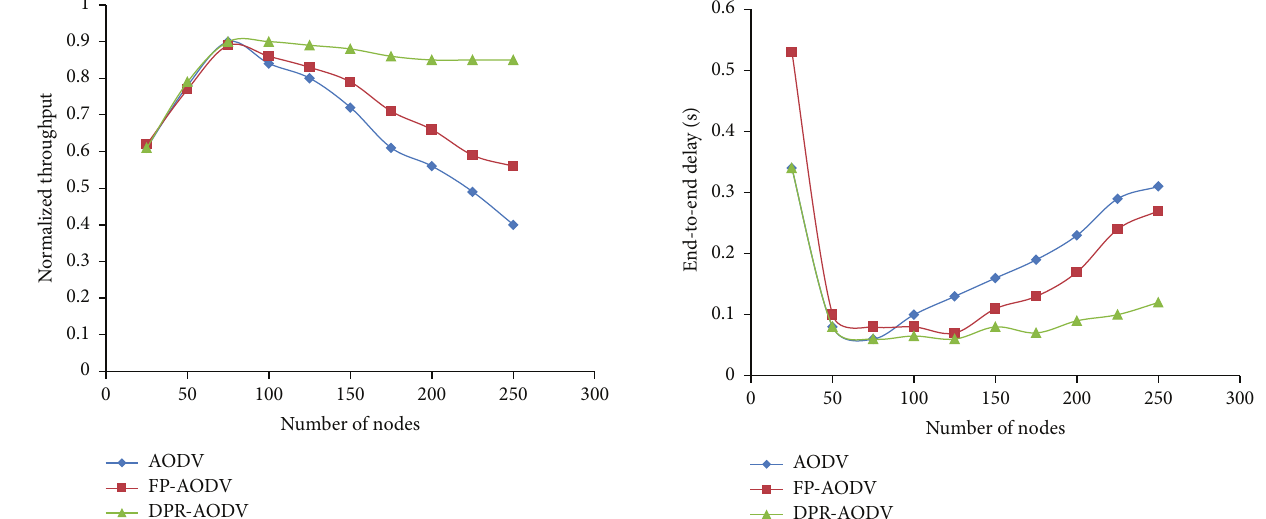
Figure 7: End-to-end delay versus number of mobile